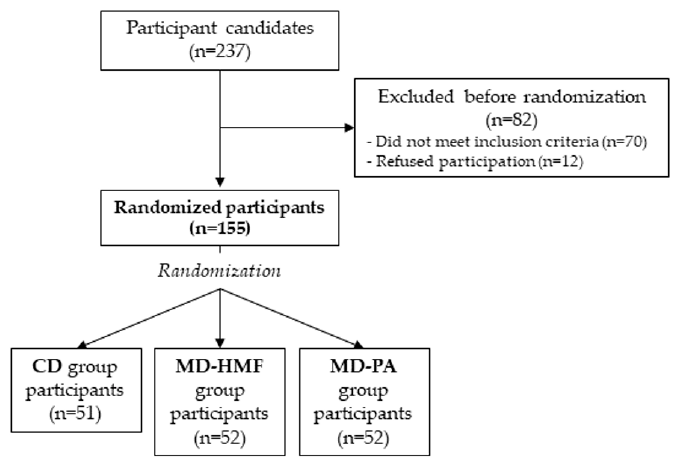
Figure 1. Study flow-chart.